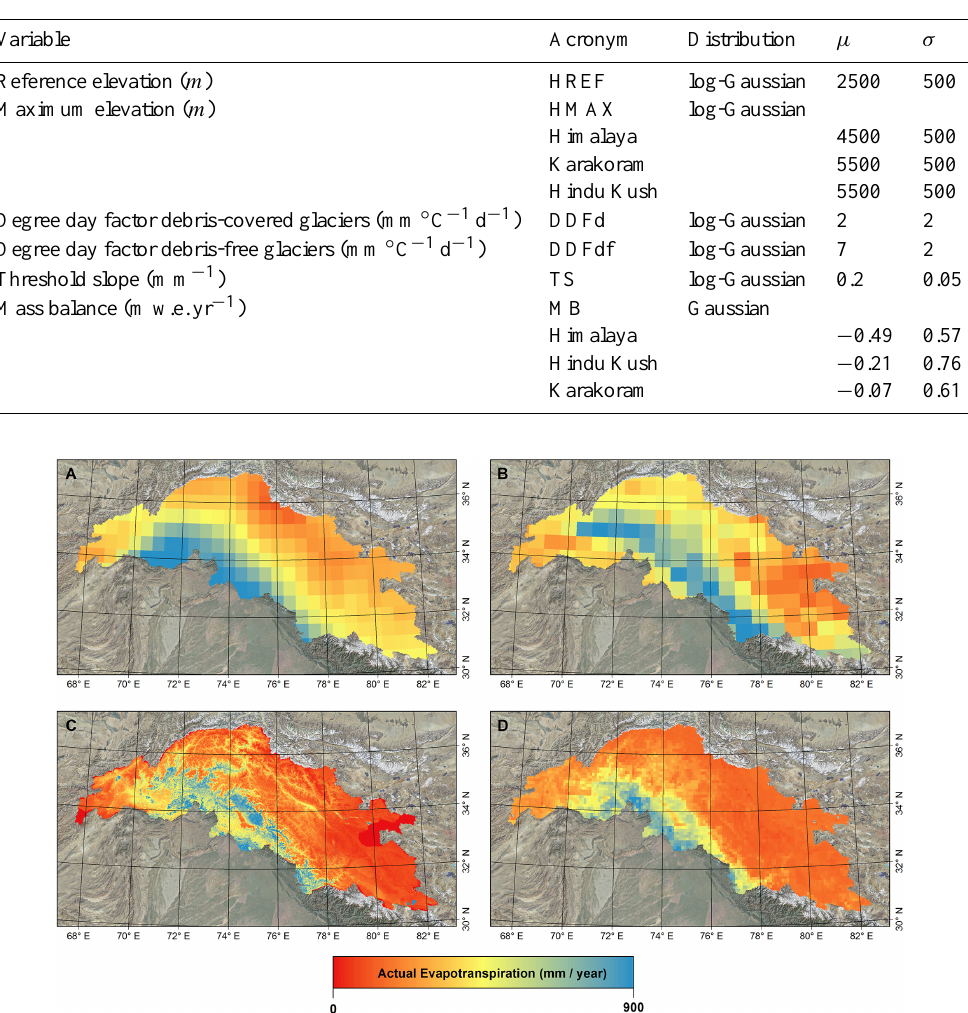
Figure 2. Average annual actual evapotranspiration between 2003 and 2007 for ERA-Interim (a) , MERRA (b) , ET-Look (c) and PCR-